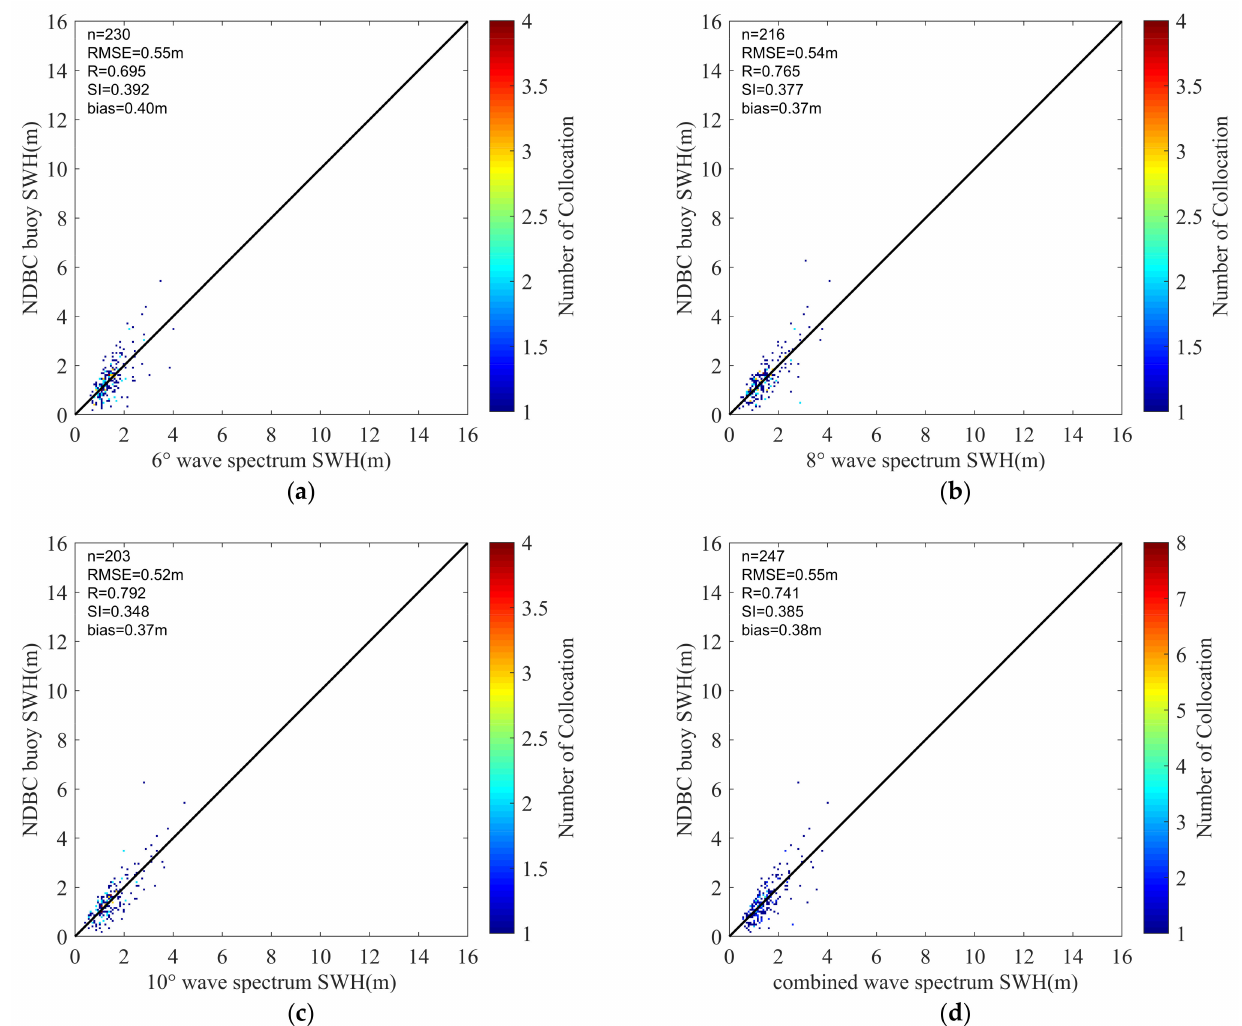
Figure 9. Comparisons between off-nadir SWIM SWH and NDBC buoy data after June 2020: ( a ) 6 ◦ beam, ( b ) 8 ◦ beam, ( c ) 10 ◦ beam and ( d ) combination of three